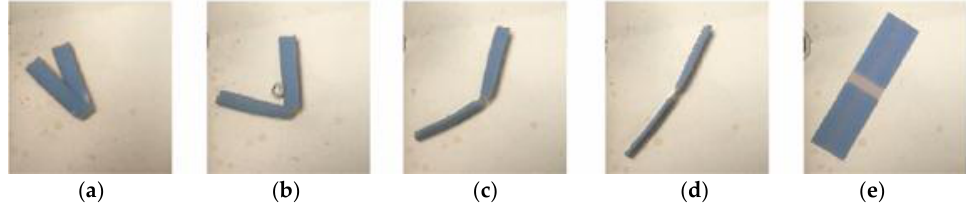
Figure 20. Method 2—the sequence of unfolding for the 0.3 mm sample from ( a ) Unfold along folding line 1; ( b ) Continue to unfold; ( c , d ) Unfolding along folding line 1 and unfold along folding line 2; ( e ) Fully unfolded specimne.